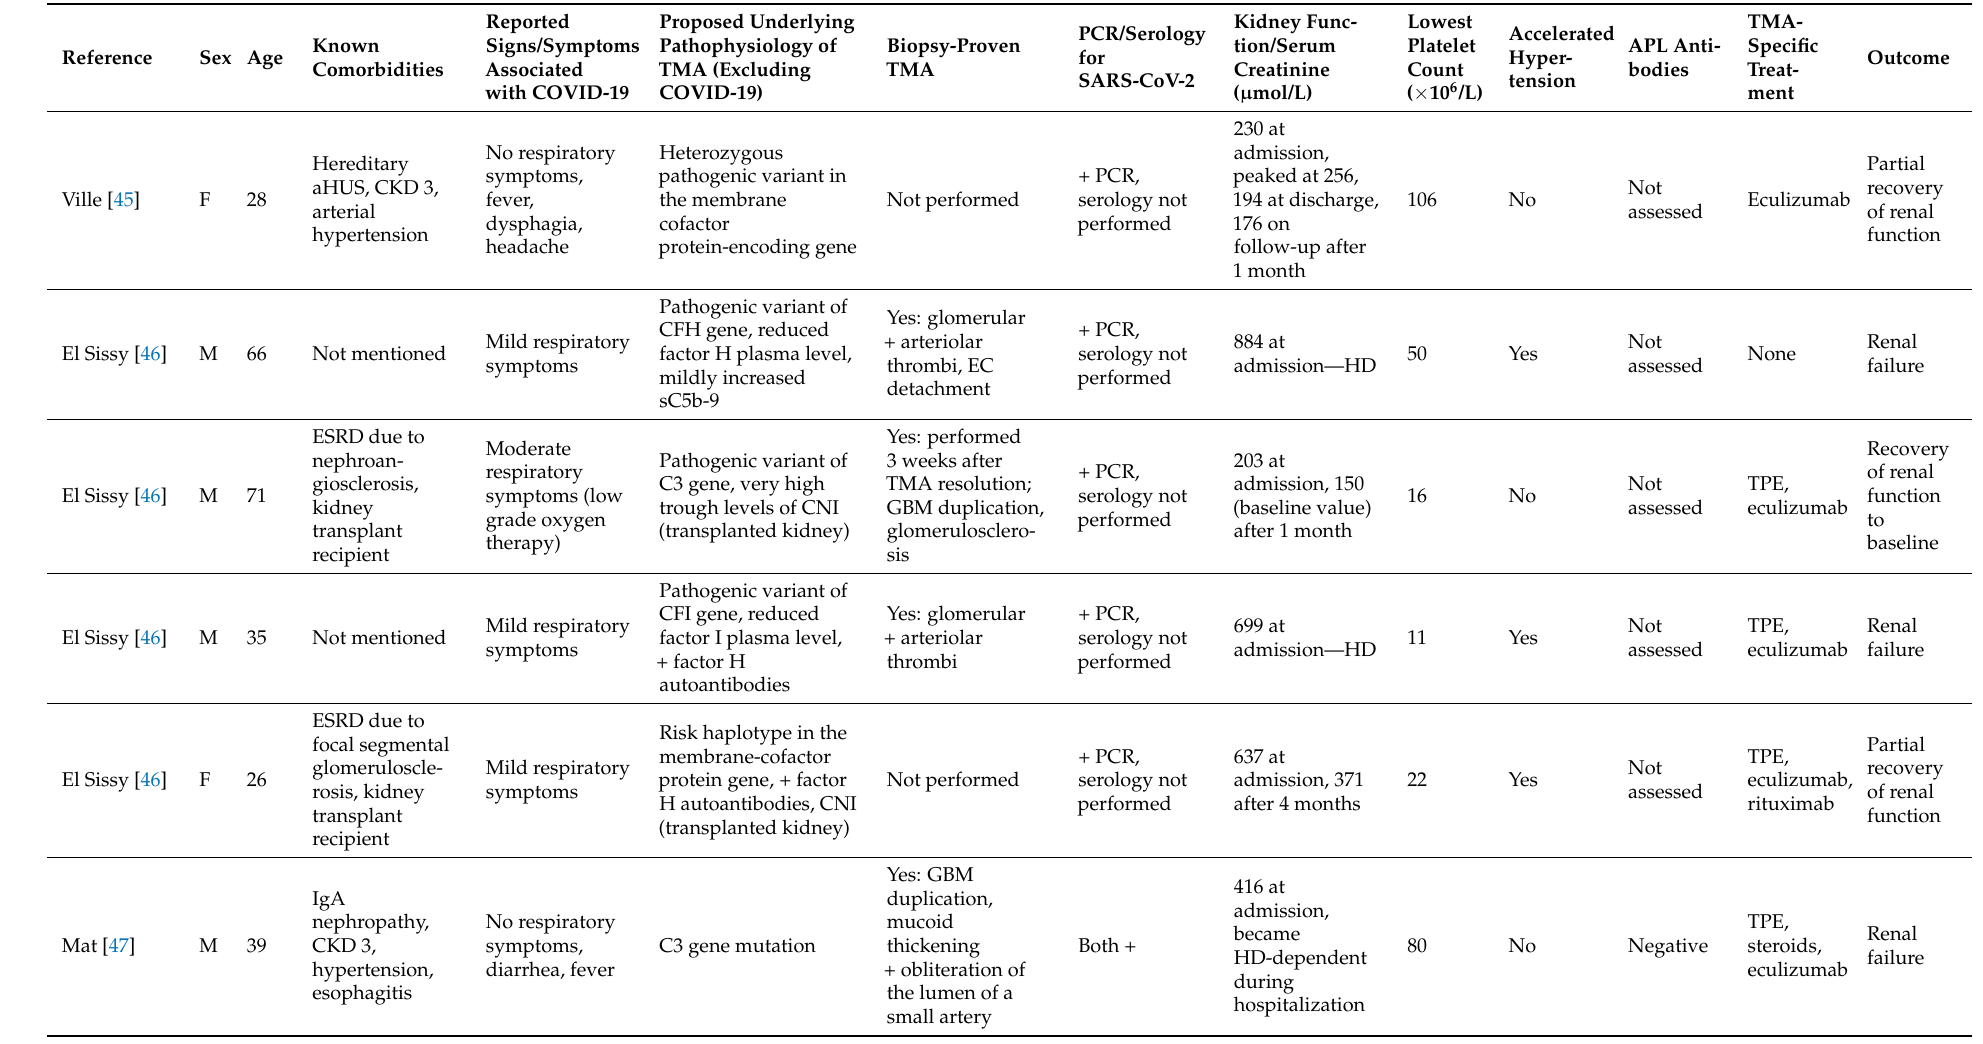
Table 2. Summary of demographic and clinical characteristics of patients presenting as COVID-19-associated